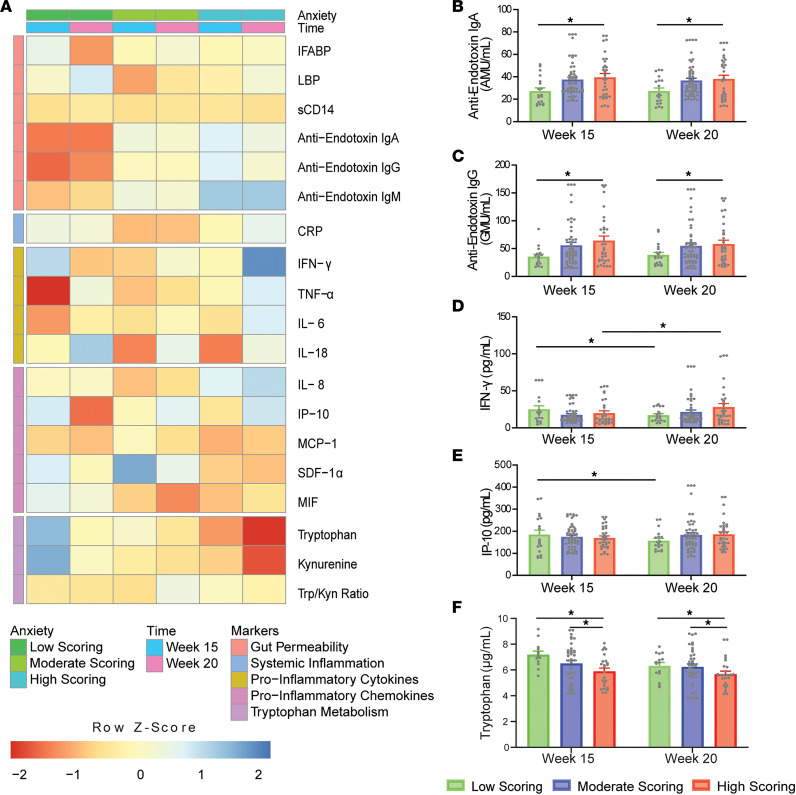
Differences in STAI-scoring groups across gestational time points in the IBS cohort (N = 19/53/33 from low/moderate/high).(A) Heatmap of normalized biomarker means across scoring groups and time points. Individual boxes are represented on a scale from red to blue. Darker red boxes represent markers whose concentrations were found to be greater than 1 standard deviation lower than the mean concentration across stress group and time point. Darker blue boxes represent markers whose concentrations were found to be greater than 1 standard deviation higher than the mean concentration across stress group and time point. Lower z scores are evident for anti-endotoxin IgA and IgG in the low-scoring group at 15 and 20 weeks, for TNF-α in the low-scoring group at 15 weeks, and for Trp and Kyn in the high-scoring group at 20 weeks. Higher z scores are evident for Trp and Kyn in the low-scoring group at 15 weeks and for IFN-γ in the high-scoring group at 20 weeks. Significant differences between STAI-scoring groups are illustrated for (B) anti-endotoxin IgA, (C) anti-endotoxin IgG, (D) IFN-γ, (E) IP-10, and (F) Trp (2-way ANOVA with Tukey’s HSD). *P < 0.05.